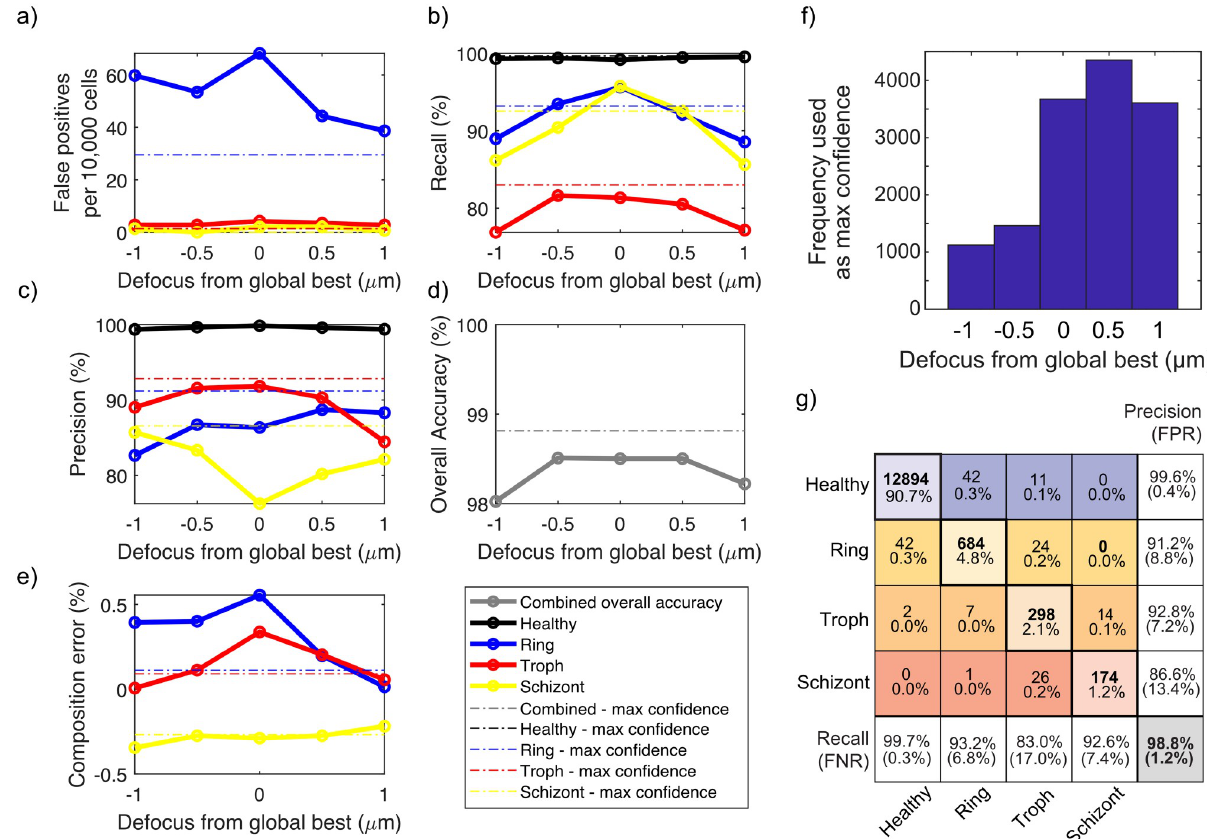
Fig 3. Analysis of classification statistics vs. focal offset in deep UV images acquired at 285 nm. In all panels, solid lines refer to statistics from processing all cells at the same global focus offset, while dashed lines correspond to using the optimal focus slice on a cell-by-cell basis, determined via the maximum confidence strategy. a) False positive rate vs. defocus from global optimum for all three parasite stages, b) Recall vs. defocus for all categories, c) Precision vs. defocus, d) Overall accuracy vs. defocus, and e) Sample composition estimation error vs. defocus. f) Histogram showing frequency of slice usage in the max confidence method. Slice number 3 is the global best focus slice, with slices evenly spaced in 0.5 μ increments. g) Resulting improved confusion matrix after applying the max confidence method. To increase the number of datapoints, all focus-dependent dataset statistics in this figure and its supplementary figures were derived from analyzing pooled classifier training and validation datasets as a function of focus slice.